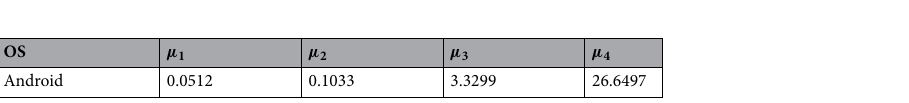
Table 1. First four central moments of the logarithmic market share development, from January 2009 to July 2021.